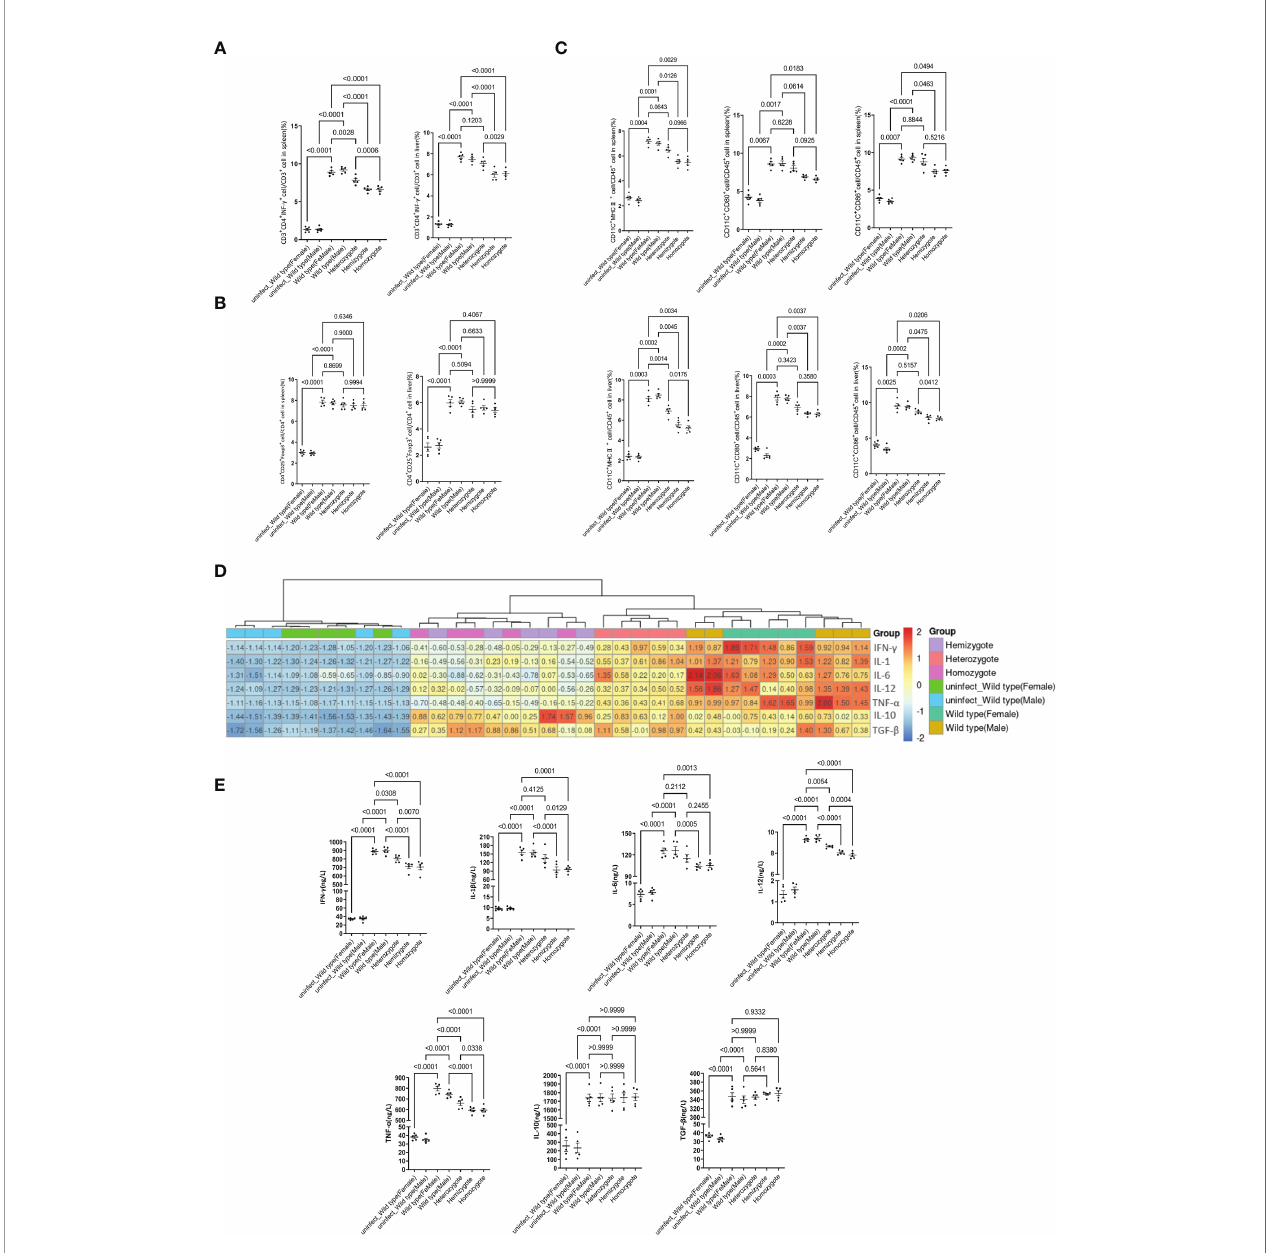
FIGURE 3 | G6pd-de fi cient mice suppresses the proin fl ammatory response after P.berghei infection. (A) Frequencies of the respective Th1 populations in the spleen and liver on day 7 post-infection. (B) Frequencies of the respective Treg populations in the spleen and liver on day 7 post-infection. (C) Frequencies of the mature DCs in the spleen and liver on day 7 post-infection. (D) Heatmap of relative cytokine gene expression in the spleens on day 7 post-infection. Expression levels were quanti fi ed by real-time quantitative PCR with b -actin as the internal reference and normalized. (E) Serum IFN- g , IL-1 b , IL-6, IL-12, TNF- a , IL-10 and TGF- b levels were quanti fi ed by ELISA on day 7 post-infection. (n=5/each group, data are representative of three independent